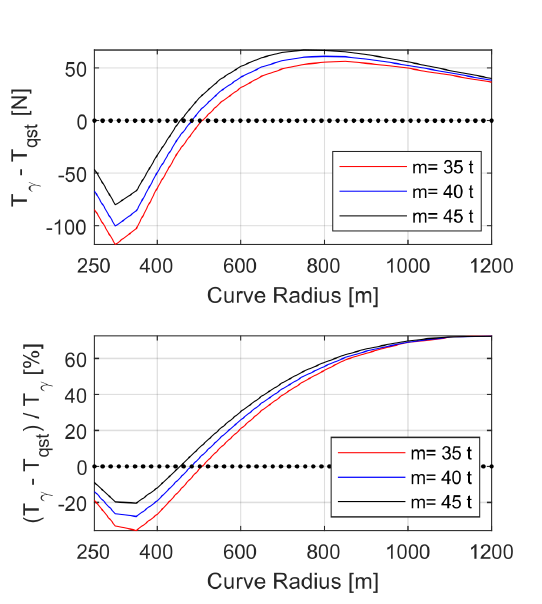
Figure 9. The difference T γ − T qst depending on the curve radius R (above) and the relative difference ( T γ − T qst ) /T γ depending on the curve radius R (be- low) for defined values of the vehicle body mass m .